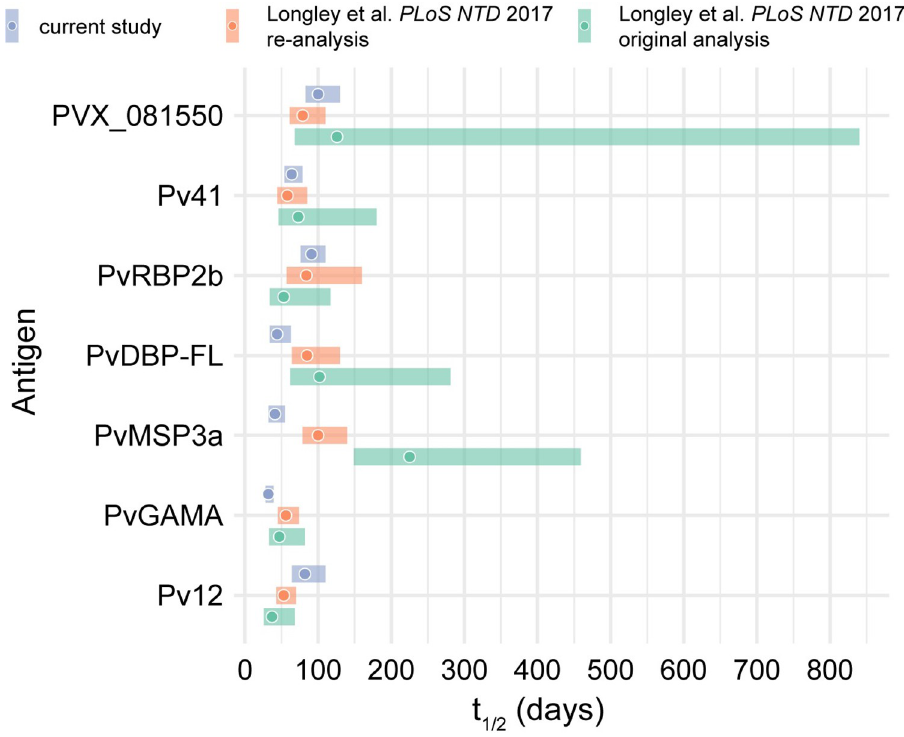
Fig 4. Comparison of IgG half-life estimates for P . vivax blood-stage vaccine candidate antigens. Reported and estimated antigen-specific IgG antibody half-lives for the Longley et al. dataset [30] and the current study. Points are half-lives estimated from linear mixed effects models (see Methods). Bands represent 95% confidence intervals. The re- analysis of the Longley et al. dataset only utilized data to 24 weeks to more closely match the current study, whereas the original analysis of the Longley et al. dataset used all available data to 9